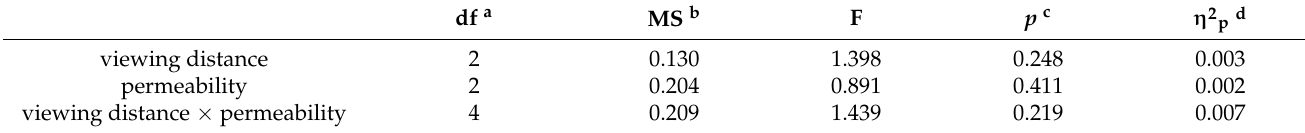
Table 9. Impacts of different viewing distances and permeability levels on (cid:52) E SDNN. df a MS b F p c η 2 p